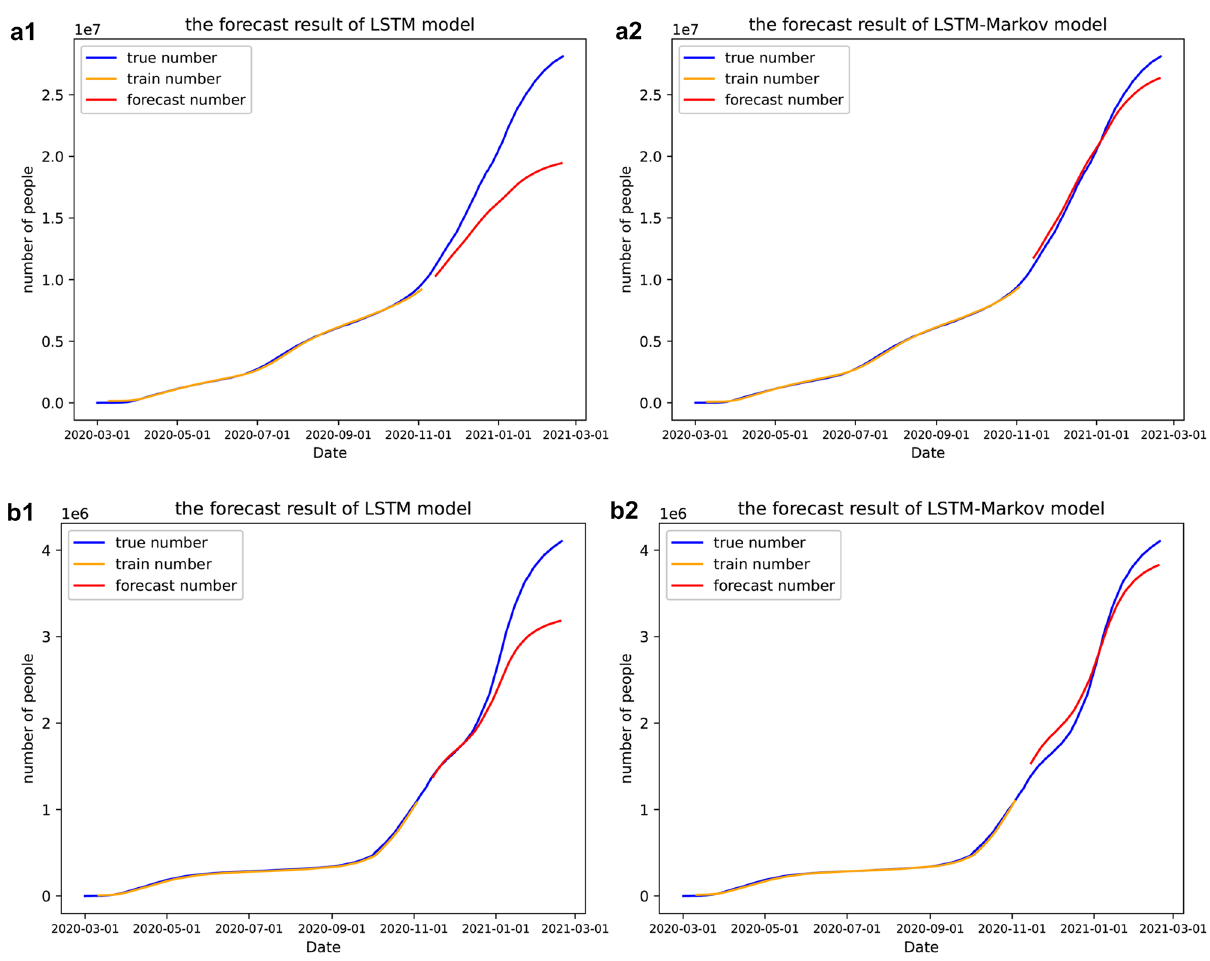
Figure 6. Prediction curves of cumulative number of COVID-19. ( a ) In the United States, ( b ) in Britain, ( c ) in Brazil, ( d ) in Russia. The blue line represents the number of reported confirmed cases, the orange line is the curve of the cumulative confirmed cases we trained, and the red line is the curve of forecasting. 1 represents the results of LSTM model, while 2 represents the results of LSTM-Markov model. (Figure was from the python